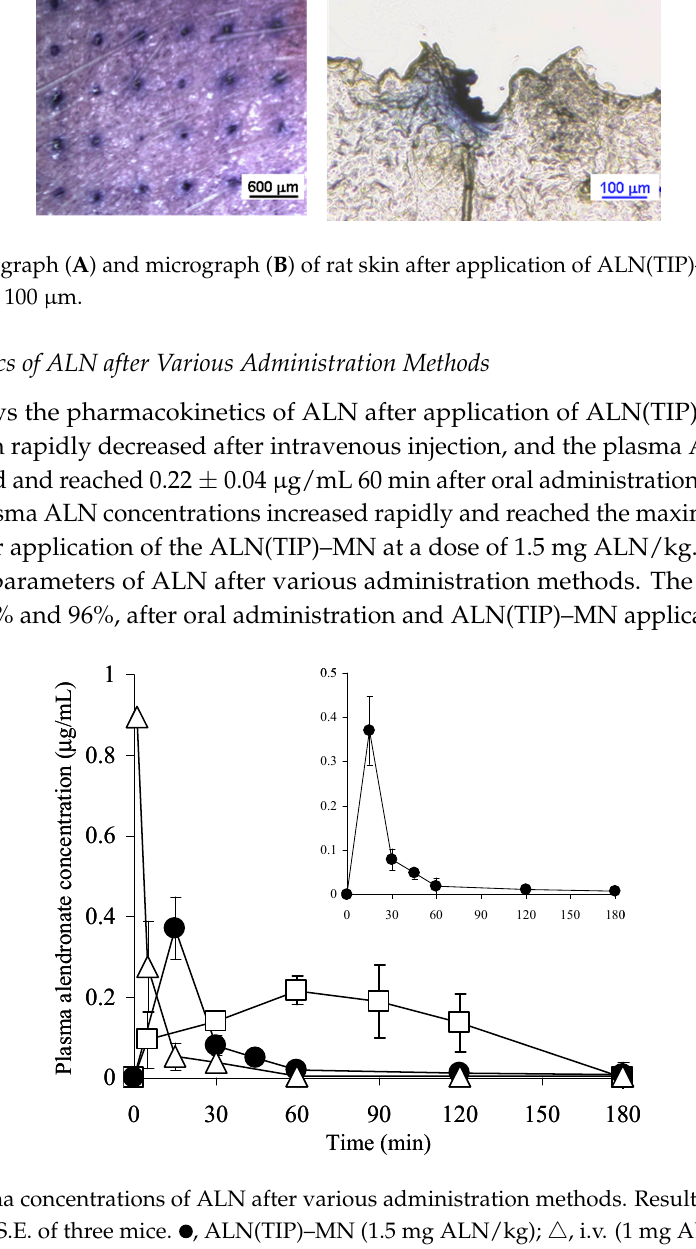
96 C max: maximum plasma concentration, T max : time to maximum plasma concentration, AUC: area under the plasma concentration-time curve, BA: bioavailability, i.v.: intravenous injection, p.o.: oral administration.